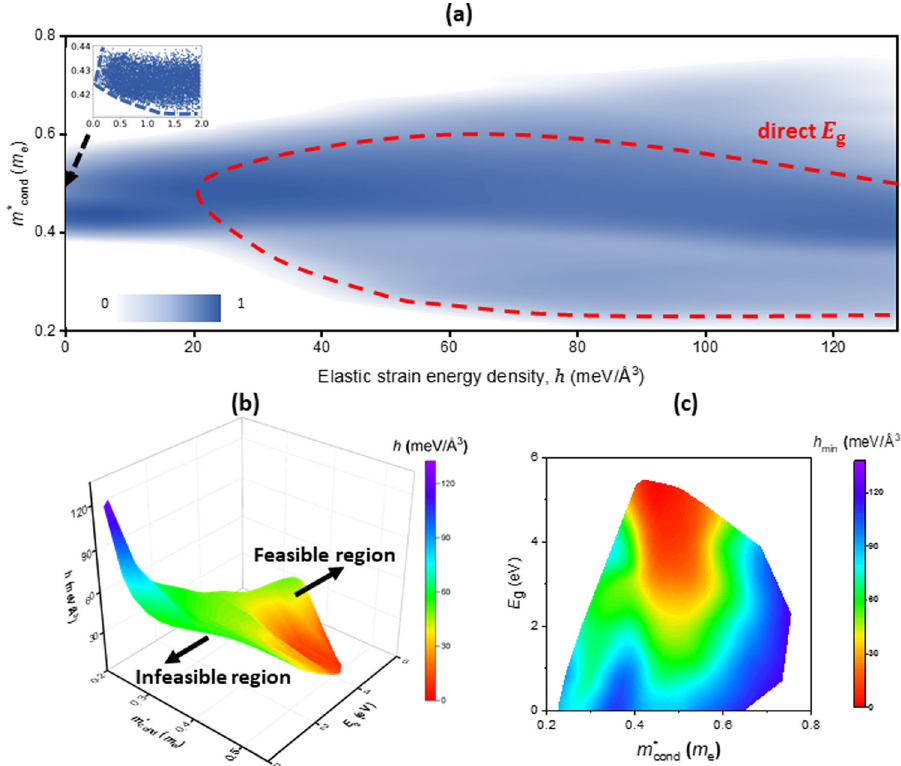
Fig. 5 ML-based exploration of electron effective mass tensor. a The density of states of conductivity effective mass. A darker shading at a given h . The red dashed line indicates the region of the possible direct bandgap implies more strains can reach a speci fi c value of m (cid:4) cond con fi gurations. Inset is the zoomed-in plot near h = 0 of the m (cid:4) distribution. b Pareto front for minimizing m (cid:4) , bandgap, and h . The color cond cond contours denoted different h values. The ( E g , m (cid:4) , h ) triplets within the Pareto front are feasible, meaning that there exist strain cases that cond can realize the three properties. c Color contours of the smallest elastic strain energy density ( h min ) required for achieving any combinations of . c is not a 2D projection of b in which only optimized (minimized) E g and m (cid:4) bandgap and m (cid:4) cond cond